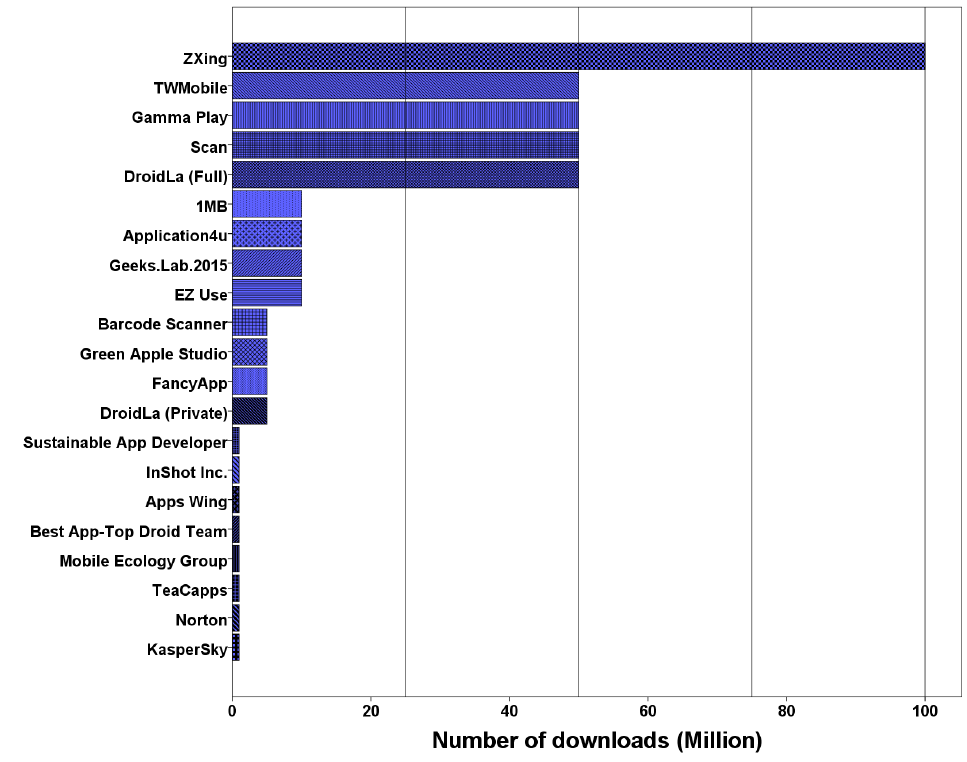
Figure 1. Popular QR Code